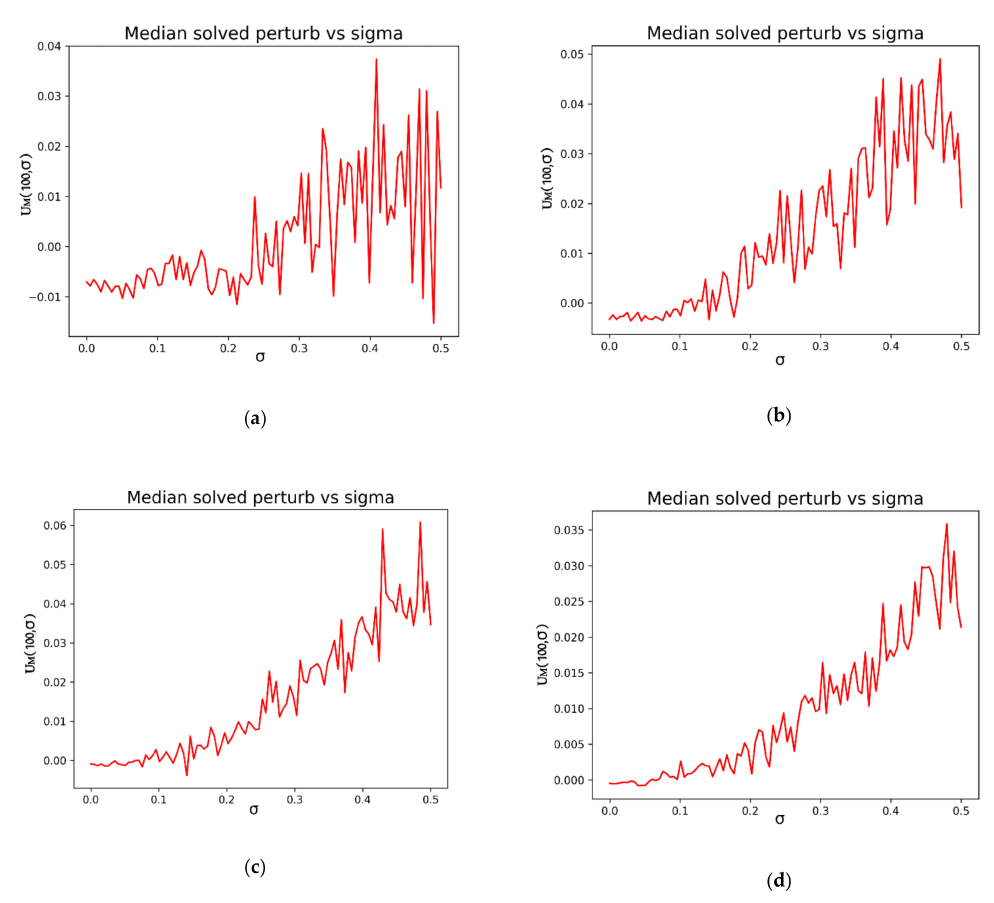
Table 1. Model parameters for the Example 1.